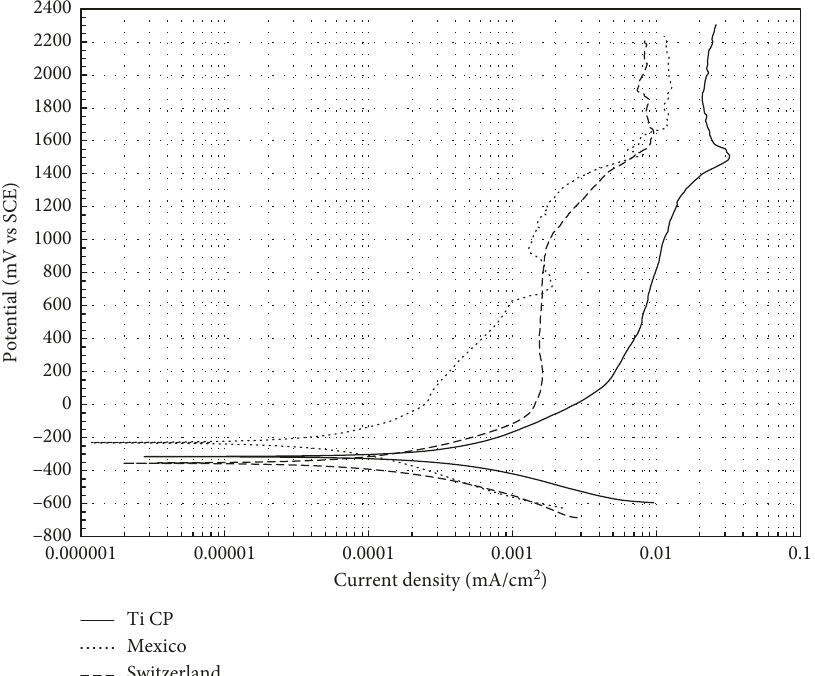
Figure 1: Potentiodynamic polarization curves for Ti biomaterials in 0.9% NaCl solution at 37 ° C (0.1667mVs − 1